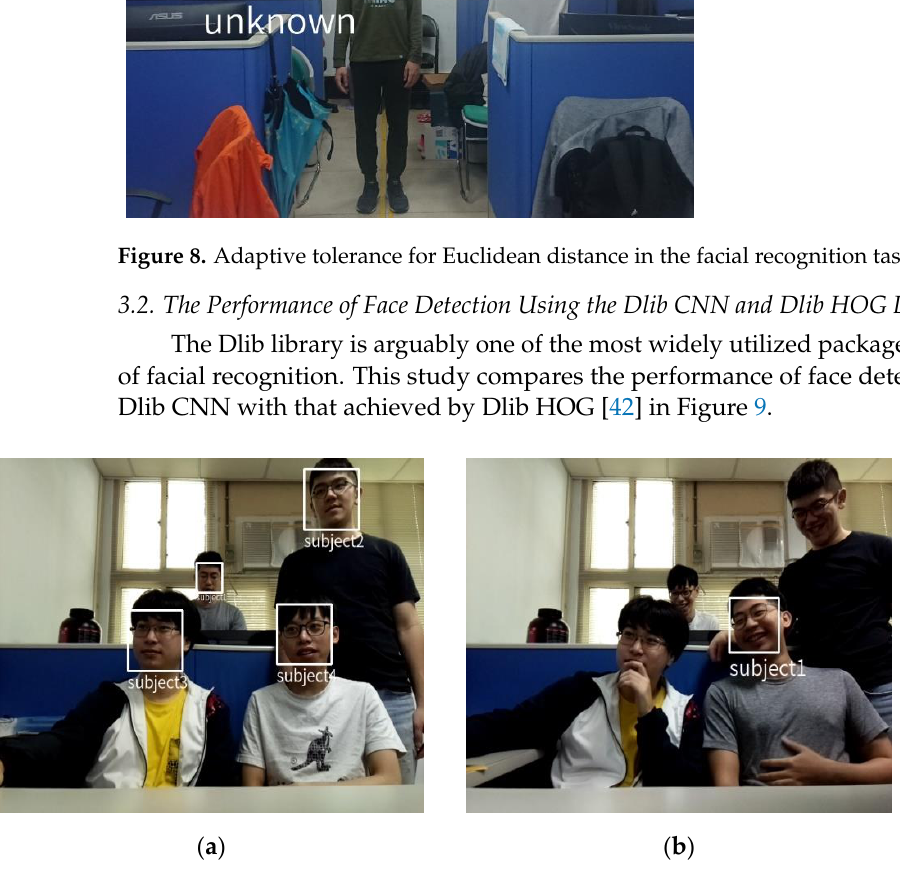
Figure 8. Adaptive tolerance for Euclidean distance in the facial recognition task.